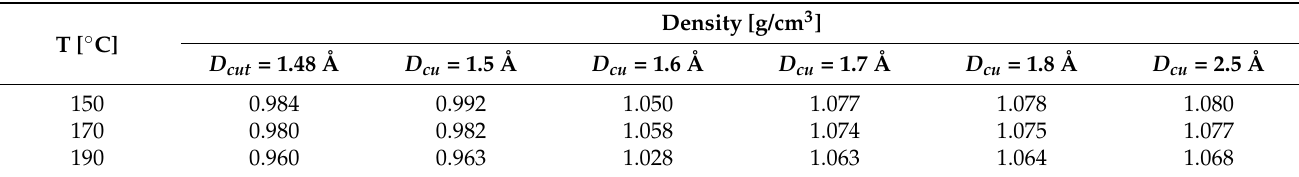
Table 4. Density of the molecular mixture at the end of the crosslinking simulation for D cut = 1.48 Å → 2.5 Å at 150 ◦ C, 170 ◦ C, and 190 ◦ C.